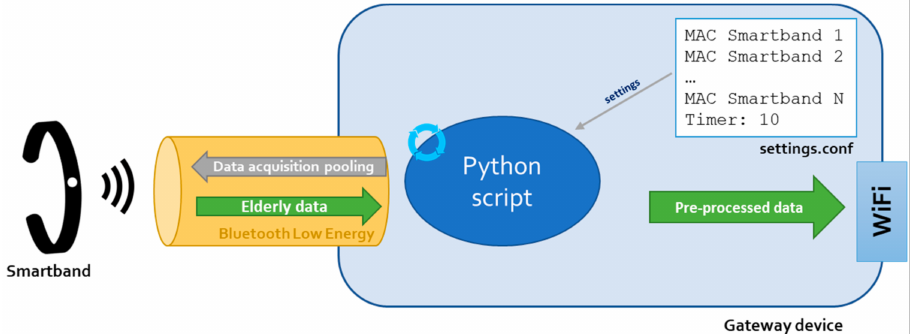
Figure 9. Gateway device operating mode.